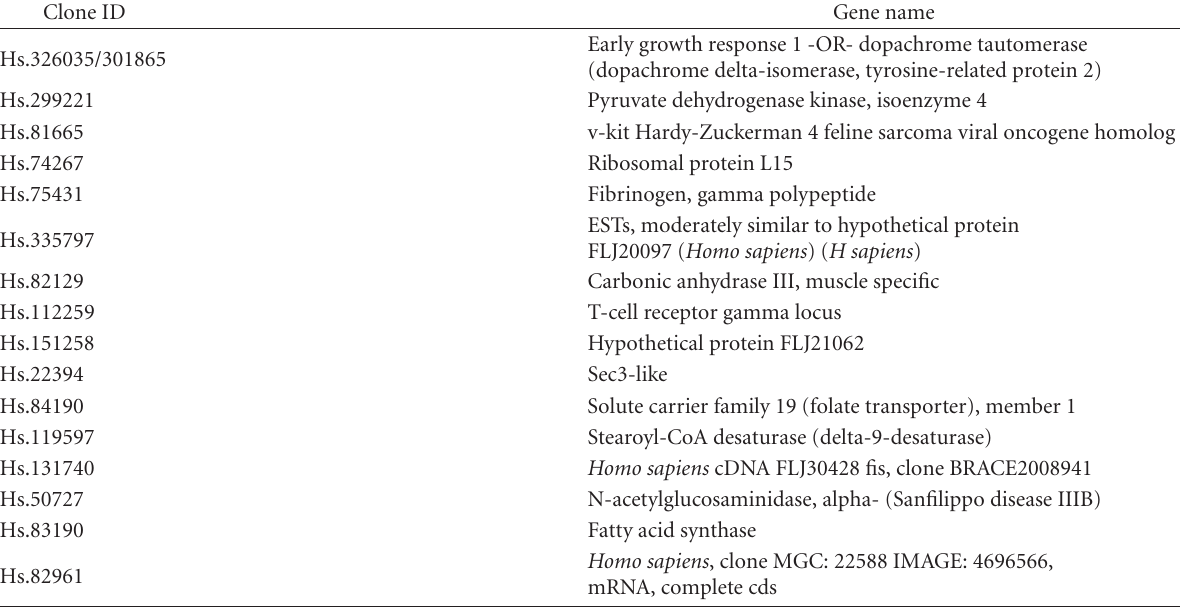
Table 3. List of genes overexpressed in prostate cancer relative to benign prostate